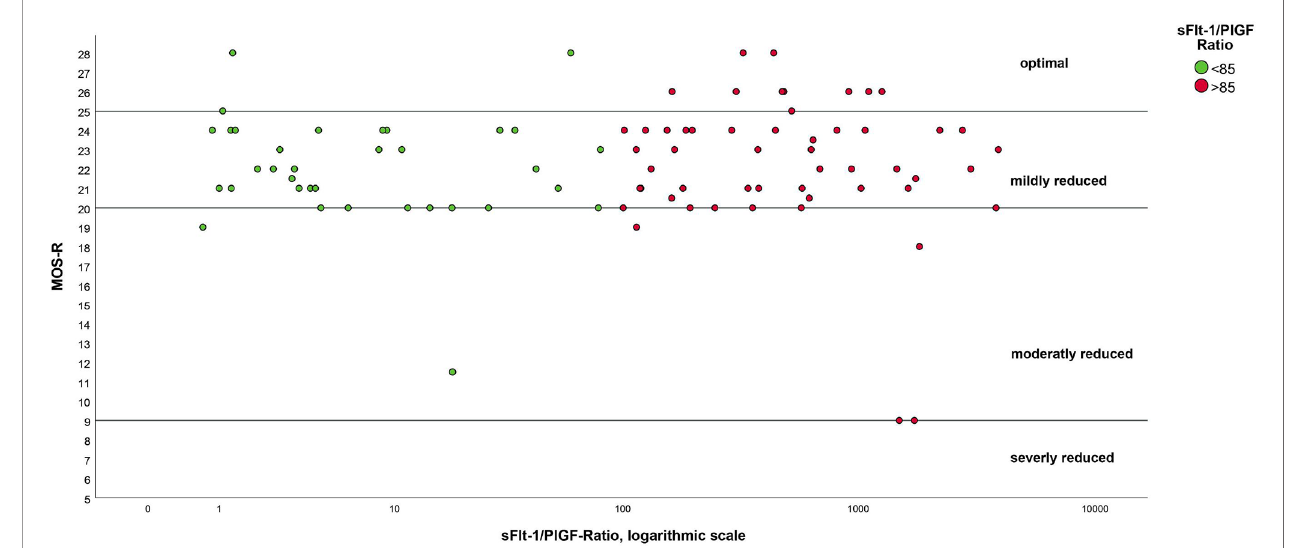
FIGURE 2 | Results of MOS-R as a function of sFlt-1/PlGF ratio. Notes. The ratio has been logarithmized for better